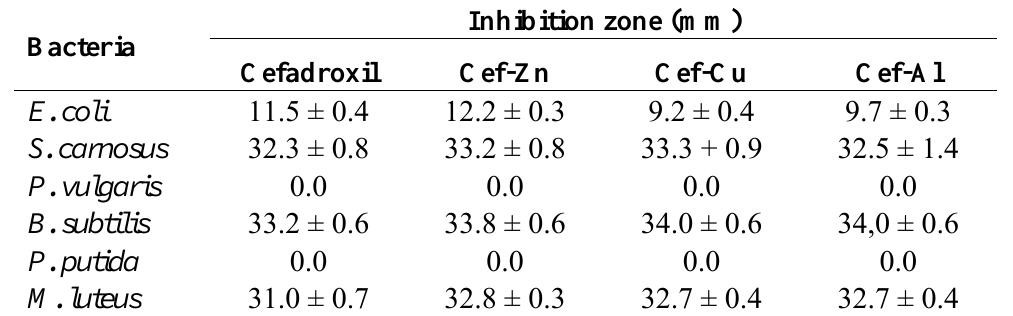
Table 1. Antibacterial activity of cefadroxil and its complexes against different